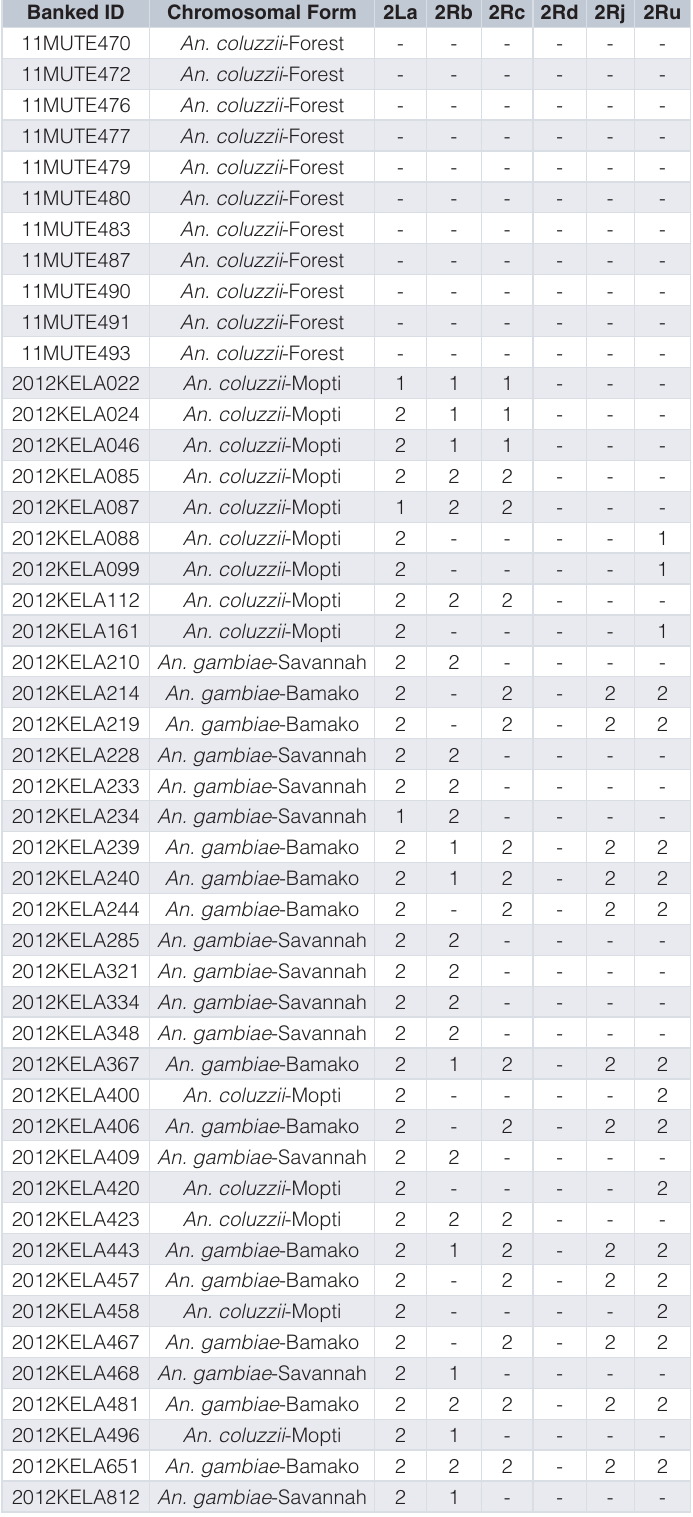
Table 1. List of detected chromosomal inversions to detect chromosomal forms of An. coluzzii and An. gambiae according Toure and co-workers (Touré et al., 1998). ‘2’ represents homozygous for the inversion, ‘1’ heterozygous for the inversion and ‘-‘ for homozygous for the standard